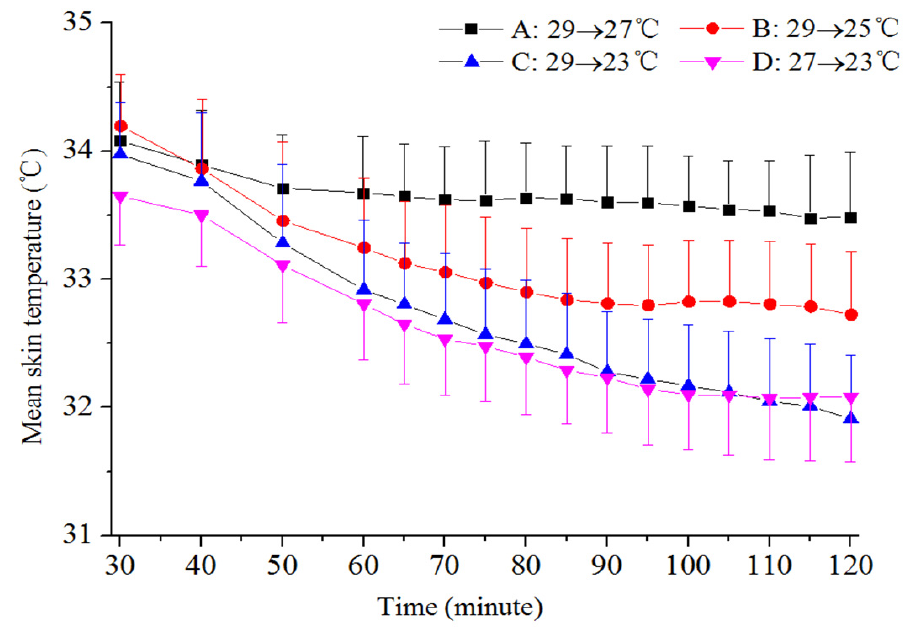
Figure 6. Mean skin temperature during scenarios A, B, C and D (mean ± SD).